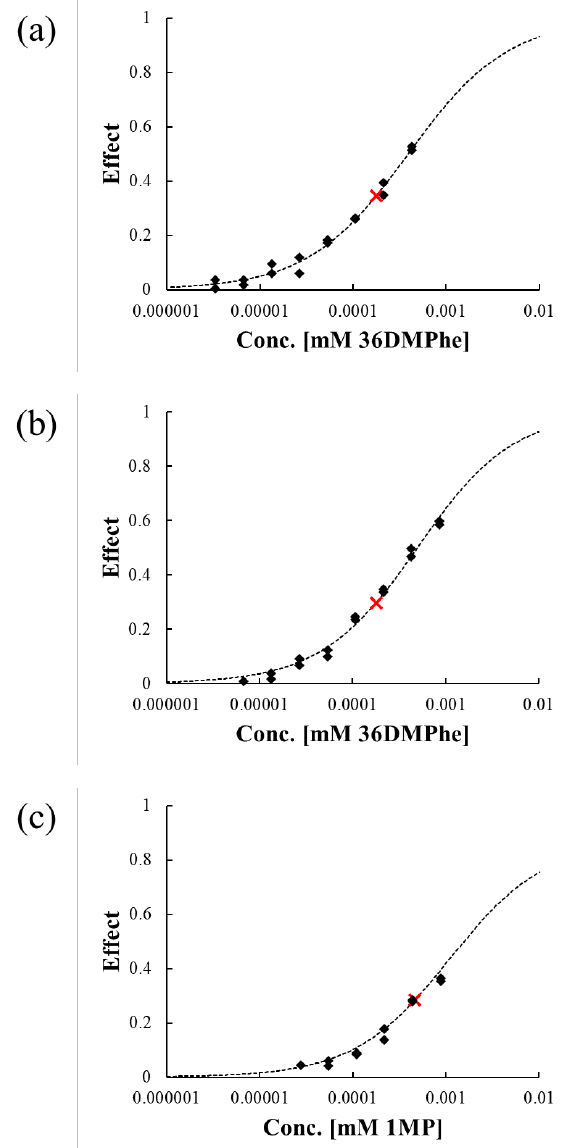
Figure 2. Dose-response curves for luminescence inhibition of A. fischeri by ( a ) 36DMP_F1, ( b ) 36DMP_F2, and ( c ) 1MP_F. The concentrations are expressed as the corresponding initial concentrations of their parent compounds. The black diamonds represent the experimental data and red cross marks represent luminescence inhibition of the isolated fractions at the water solubility of the parent compounds.